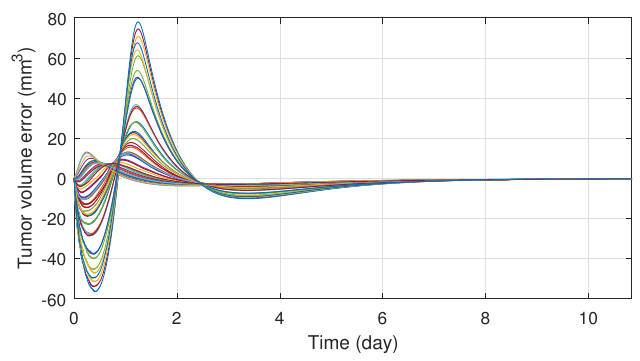
Figure 6. Tracking errors under parameter